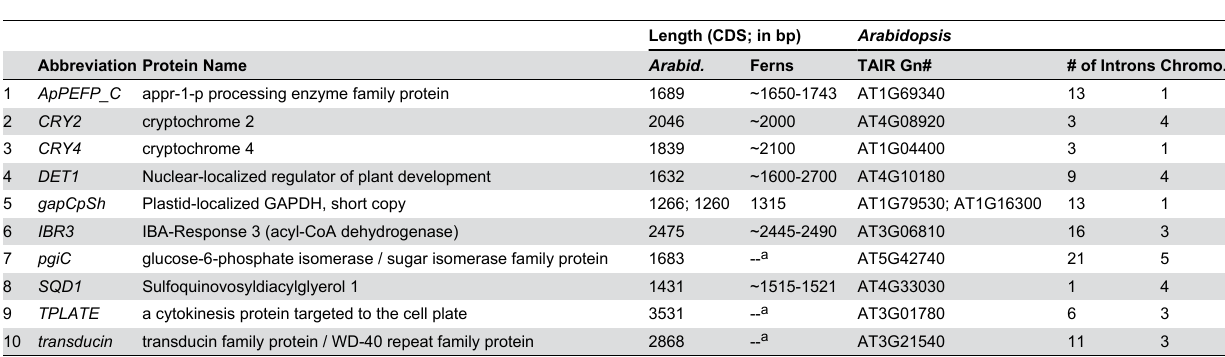
Table 1. Summary of the genes for which we designed primers.